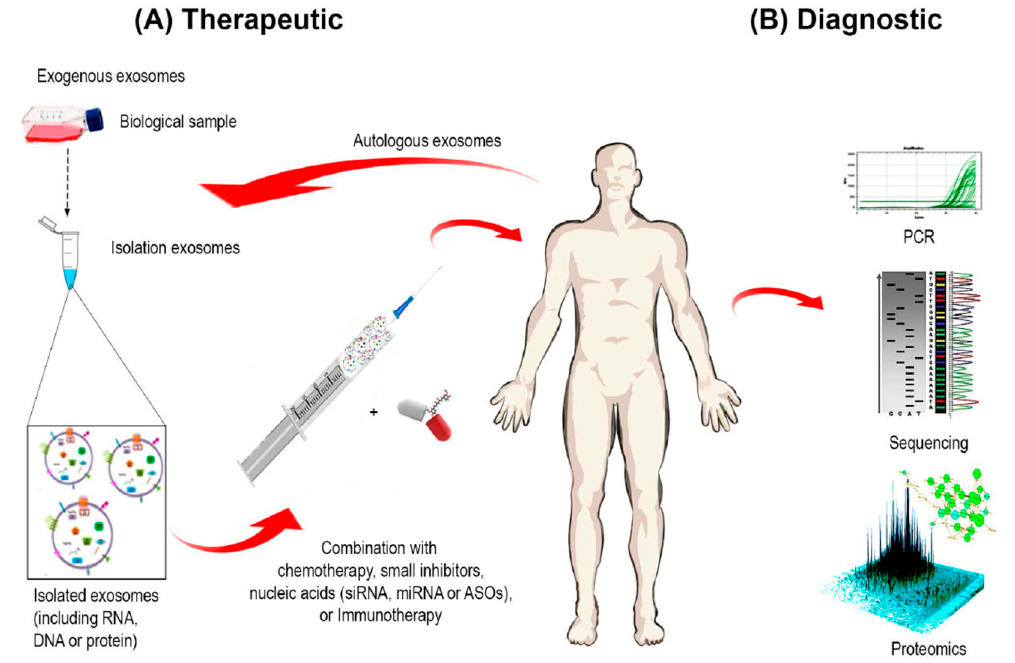
Figure 4. Exosome-based Diagnostics and Therapeutics. Exosomes hold a potential to be used as therapeutic or diagnostics tools. ( A ) Therapeutics: Exogenous or autologous exosomes can be isolated to deliver a desired payload in combination with chemotherapeutics, adjuvants of chemotherapy or as immunotherapy; ( B ) Diagnostics: Biomarkers can be determined to evaluate the expression of proteins, inflammation markers or nc-RNA present in exosomes from biological fluids.